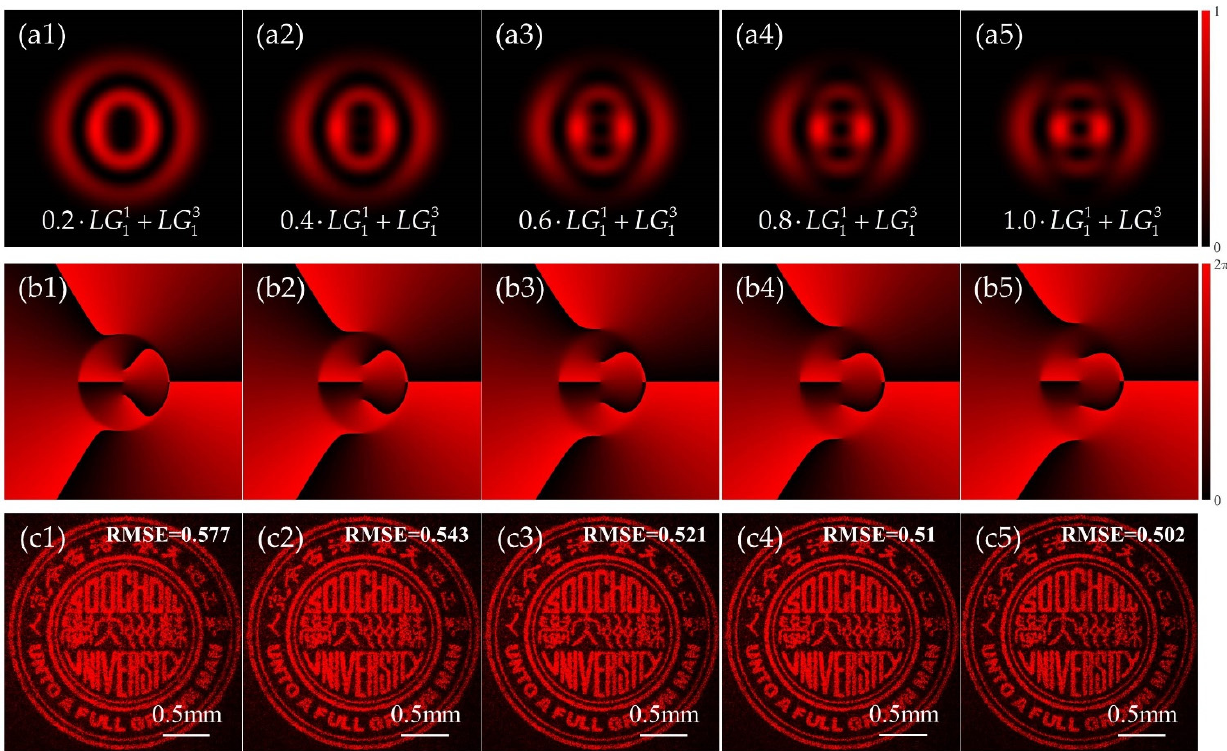
Figure 9. Analysis of the Soochow University logo CGH for different composite OAM beam energy ratios. ( a1 – a5 ) The intensity and ( b1 – b5 ) phase distributions of the composite OAM beams; ( c1 – c5 ) experimental far-field images for different beam energy ratios.